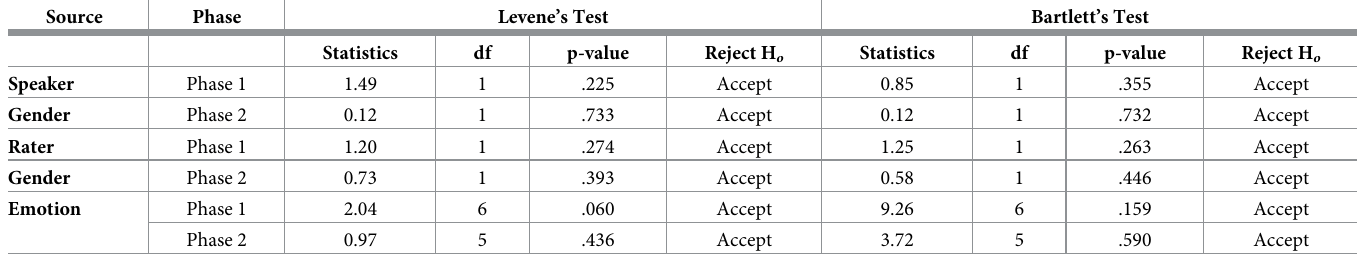
Two-way ANOVA was conducted on log transformed data to find out Gender and Emotion interaction effects. It was calculated for the rater and speaker genders separately, for both phases, at the significance level of p < 0.05. The independent variable in all cases was the raw hit rate. For rater gender at Phase 1, the main effect of Gender was statistically significant for emotion perception at the condition of F(1,336) = 11.96, p < .001. Emotion also has a signifi- cant main effect on average hit rate where F(6,336) = 58.95, p < .001. Two-way interaction between Gender and Emotion was also significant for F(6,336) = 2.59, p < .05. Table 14 shows the summary results for this phase. For Phase 2, from Table 15 it is seen that the main effect of rater Gender was statistically significant for F(1,288) = 6.58, p < .05. The main effect of Emo- tion was also statistically significant, where F(5,288) = 53.94, p < .001. But the two-way interac- tion between Gender and Emotion was not statistically significant, where F(6,336) = 0.11, p > .05. Tables 16 and 17 show the results of a two-way ANOVA between Speaker Gender and Table 13. Homogeneity test for Gender and Emotion-wise data. Source